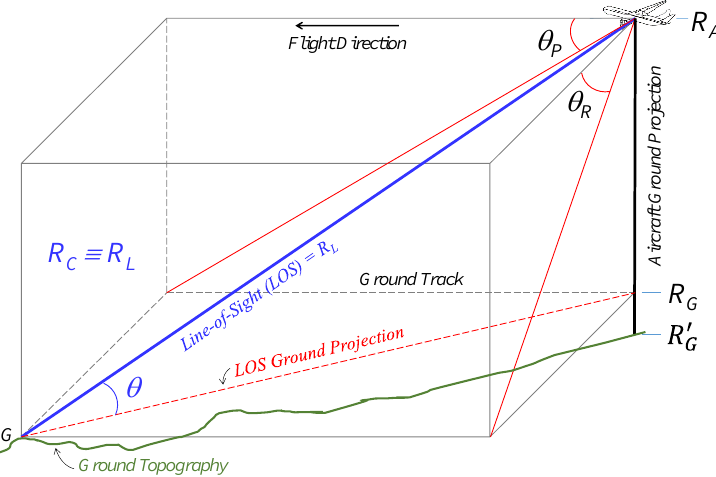
Figure 7. A schematic for IPDA sensing column length, R C , equivalent to line-of-sight, R L (blue line), calculated using airborne altitude, R A , ground elevation, R G , and the range correction factor estimated from aircraft roll and pitch angles, θ R and θ P , respectively. R C is measured using the pulsed IPDA lidar itself, using time-of flight technique. Range correction factor is applied for transforming MGD and standard atmospheric models from aircraft ground projection line to LOS.